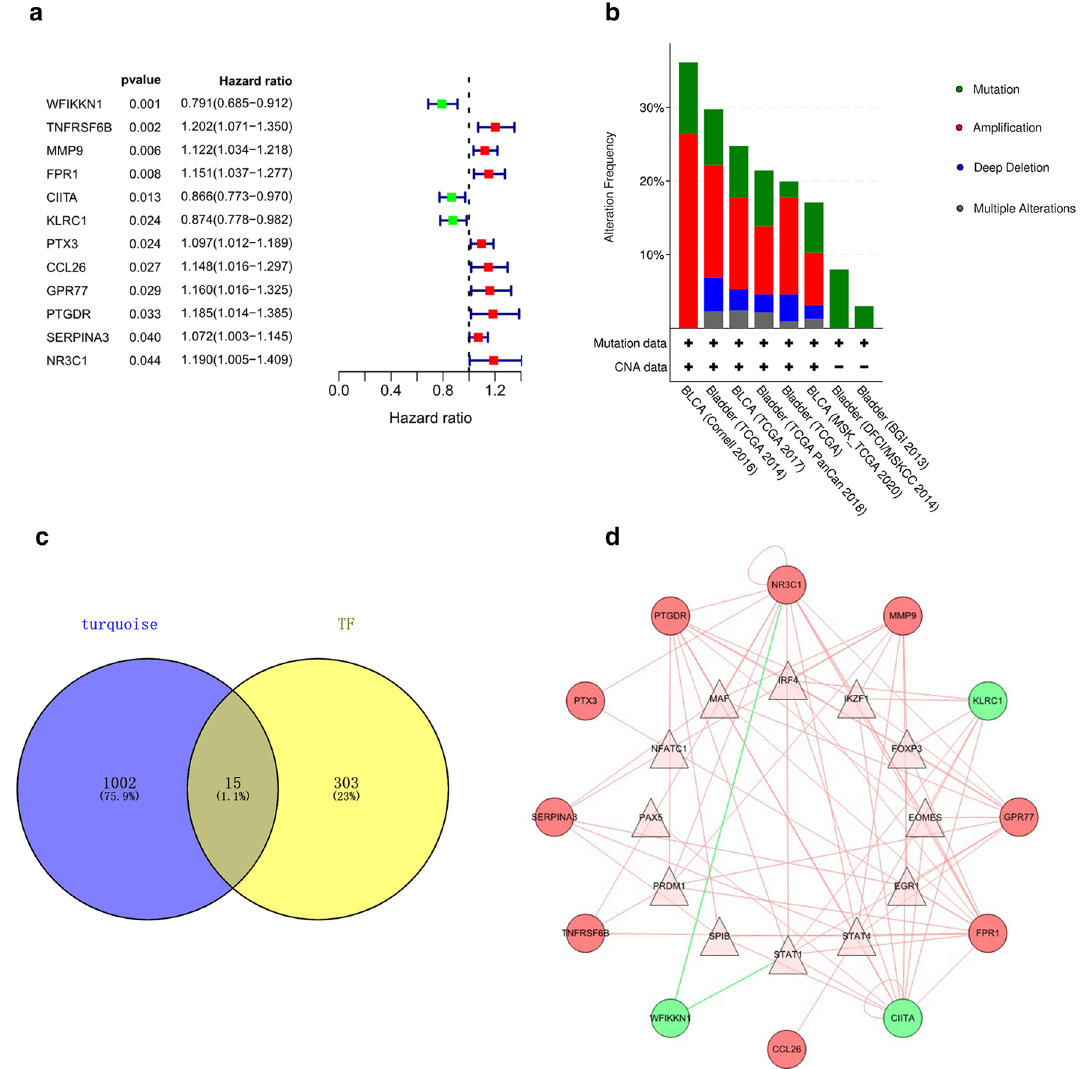
Figure 3. Regulatory network analysis of PIRMGs and module-related TFs. ( a ) A forest plot demonstrated the 12 IRMGs identified by univariate Cox regression analysis (p-value < 0.05). Right panel illustrated the hazard ratio of 12 IRMGs, in which red box indicated HR > 1 and light-blue indicated HR < 1. ( b ) Alteration analysis of PIRMGs by online database cBioPortal. The “+” and “−” symbols indicated that whether the alterations in DNA levels can be detected or not in corresponding dataset. ( c ) Identification of 15 module-related TFs (overlapping area) by intersection of 1017 MGs (circle at left) and 318 TFs (circle at right). ( d ) A regulatory network of the significant correlations of PIRMGs (circle) and module-related TFs (triangle). Lines indicated correlations. Red or light-blue indicated positive or negative correlation,